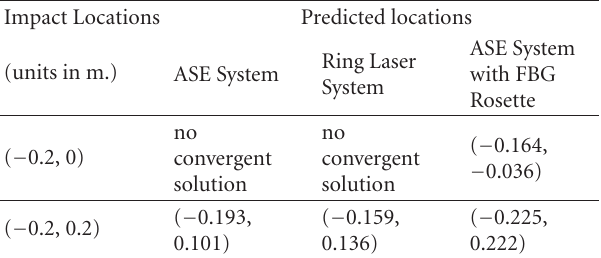
Table 1: Comparison of prediction accuracy among systems using single FBG and FBG rosette. Impact Locations Predicted